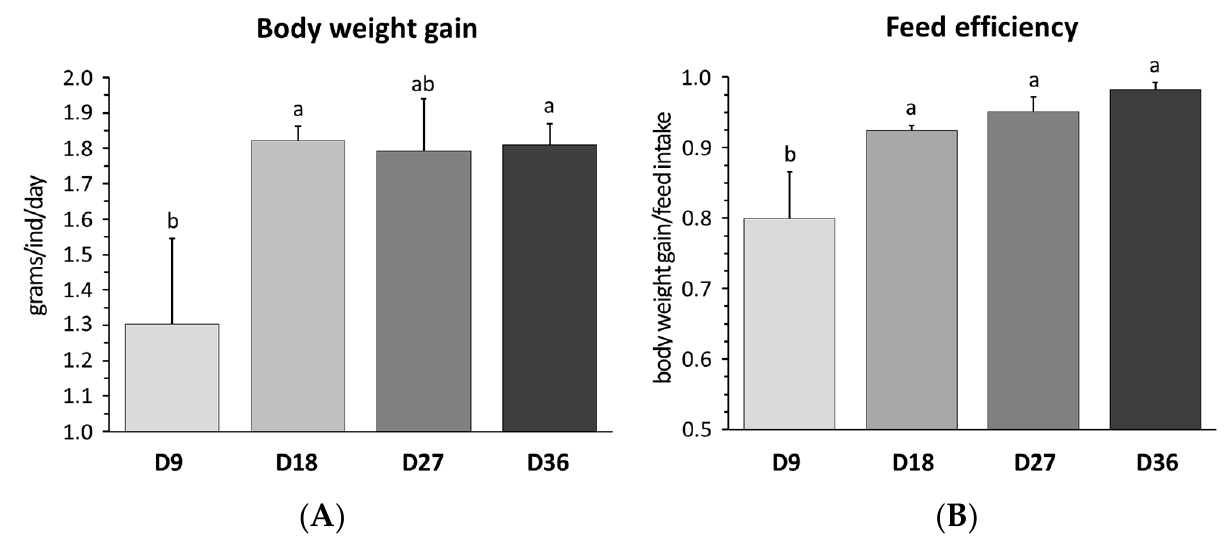
Scheme 2. Effect of stocking densities on production parameters of hand-fed rainbow trout.